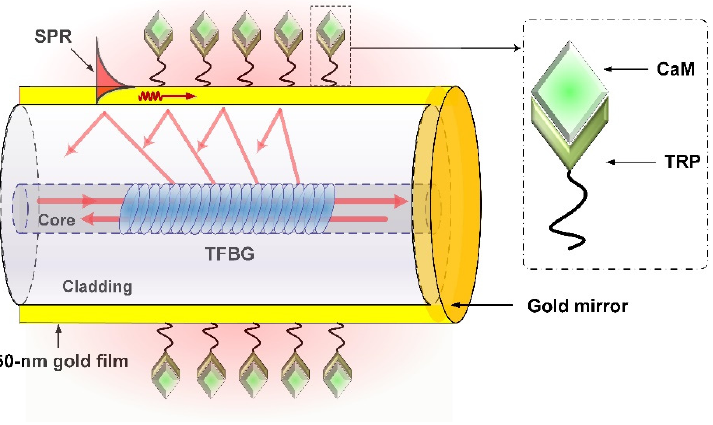
Figure 2. Detail of the proposed sensor.